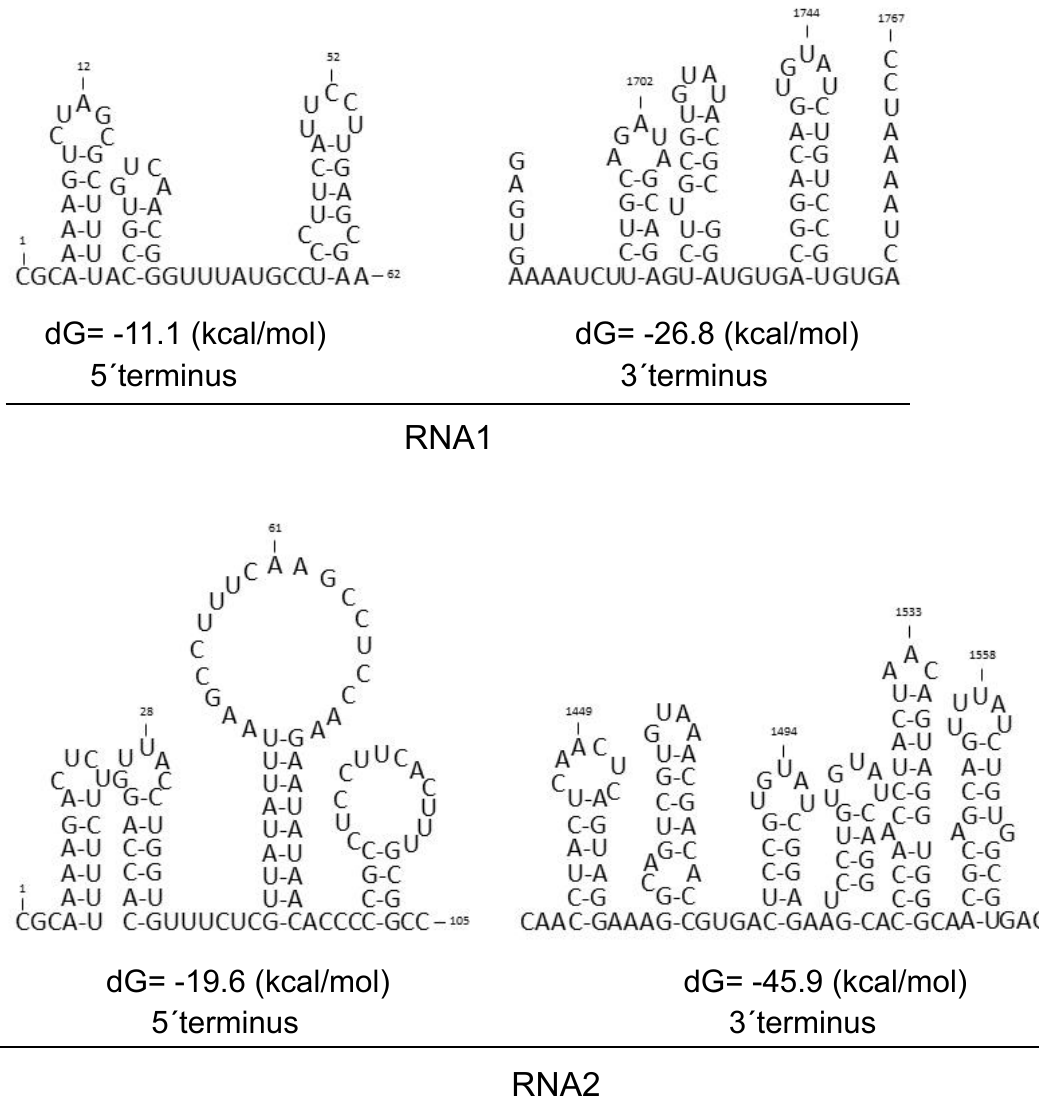
Supplementary Figure 2. Potential predicted secondary structures of the 5´and 3´UTRs of the coding strand of dsRNAs 1 and 2 of VdPV1-ol. The RNAs were folded and the lowest energies were estimated using RNAstructure software (Mathews, 2014).